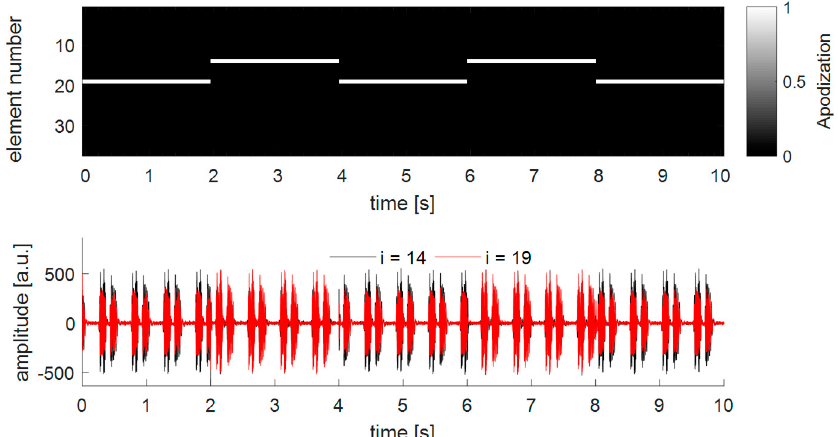
Figure 12. Illustration of a special behavior of the DAA1-method. In the experiment, the chicken heart is centrally located in front of a curved transducer array and beats at fHR = 120 bpm. During the experiments, the dynamic apodization adaptation method using a single element (DAA1) was used. The top graph shows the set apodization function over time and the bottom graph shows the Doppler signal received with element i = 14 and i = 19. For visualization, the time delay caused when updating the apodization function was removed from the apodization and Doppler signal graph.